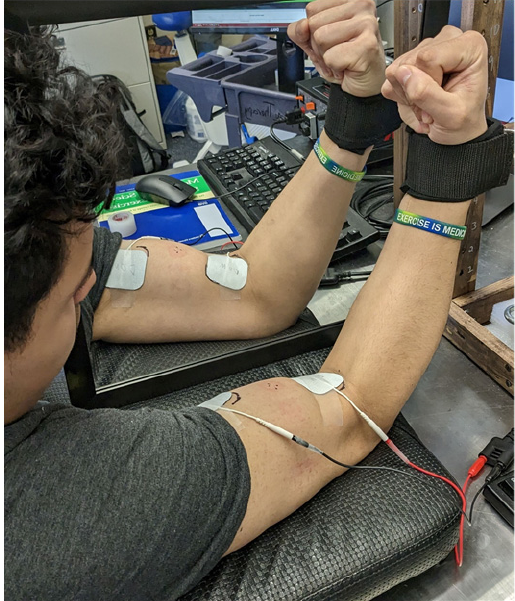
Figure 1. Experimental setup for a subject from the NMES + MVF group.